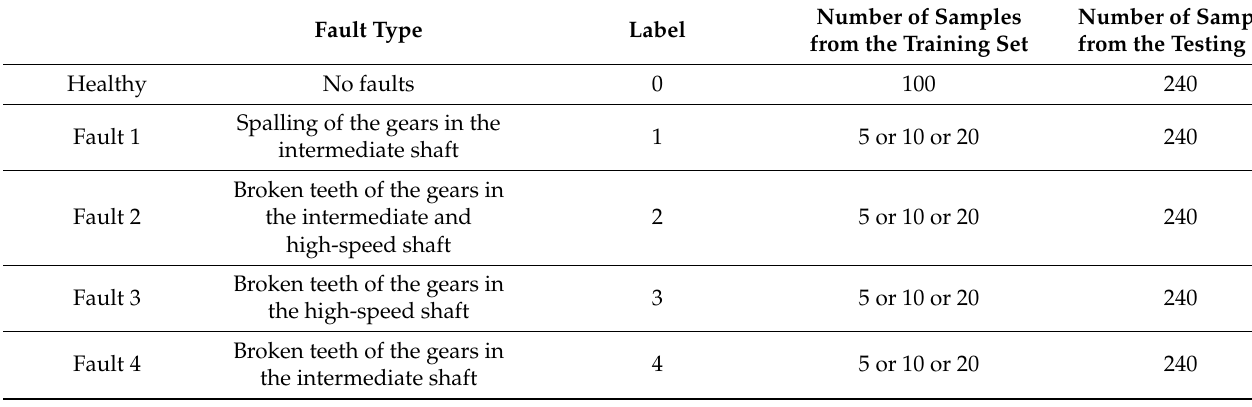
Table 2. Fault description of the wind turbine gearbox.